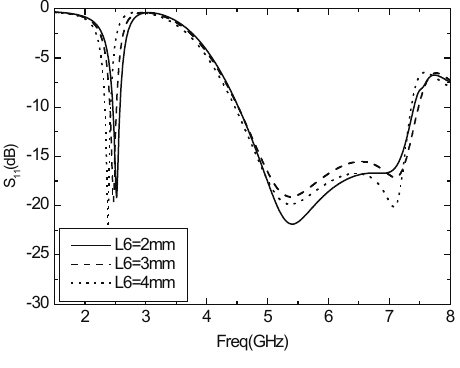
Figure 8. Parameter S 11 varies with L6.